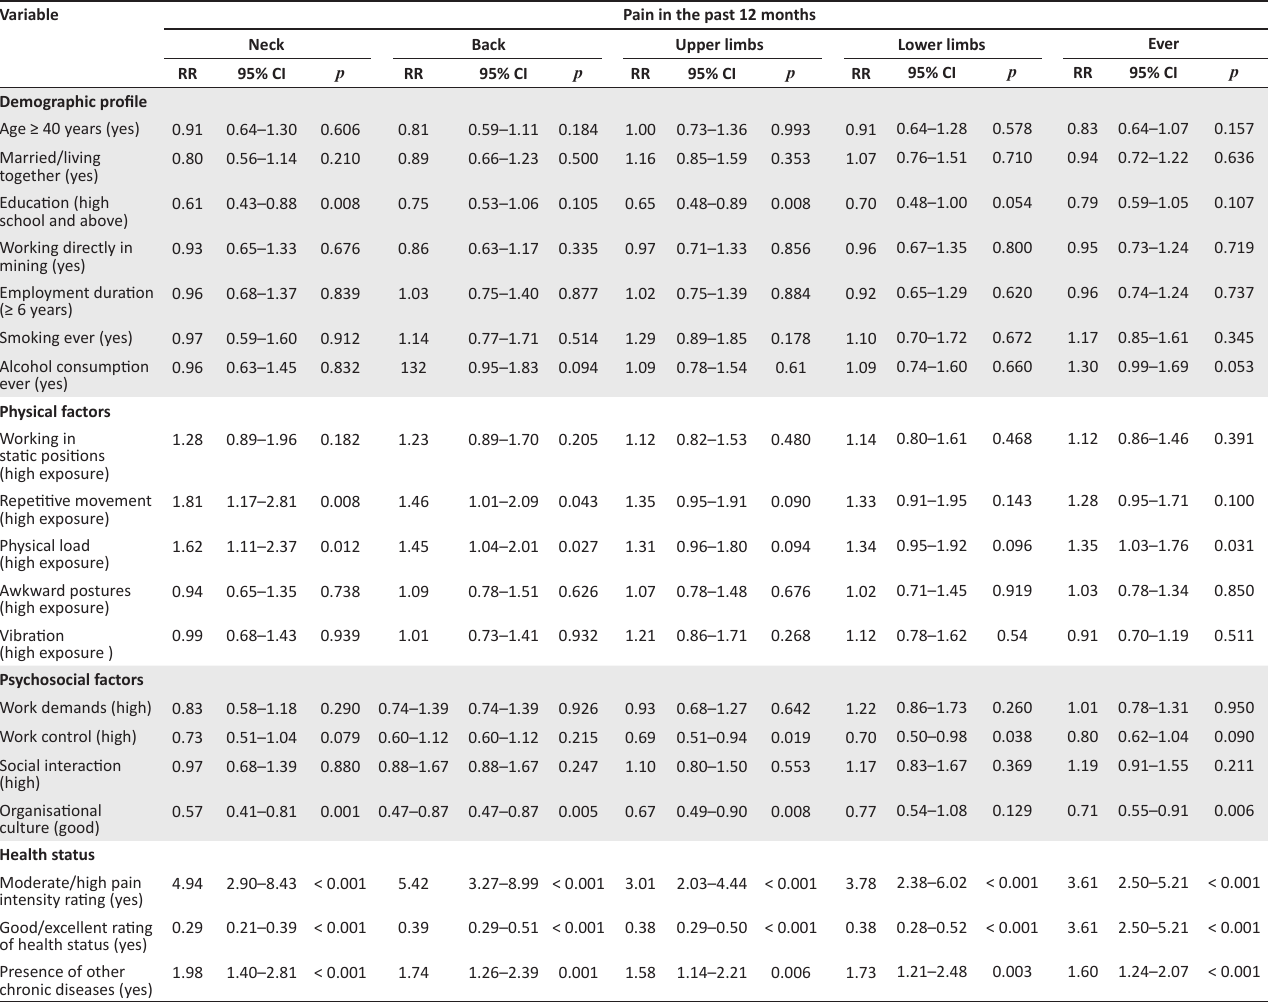
TABLE 4: Crude associations of demographics, physical and psychosocial factors, health status and pain in the past 12 months amongst female miners in a South African gold mine in 2017.